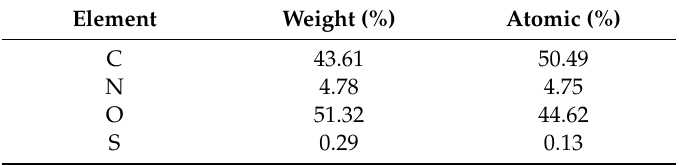
Table 1. The elemental composition of the ternary composite film from EDX